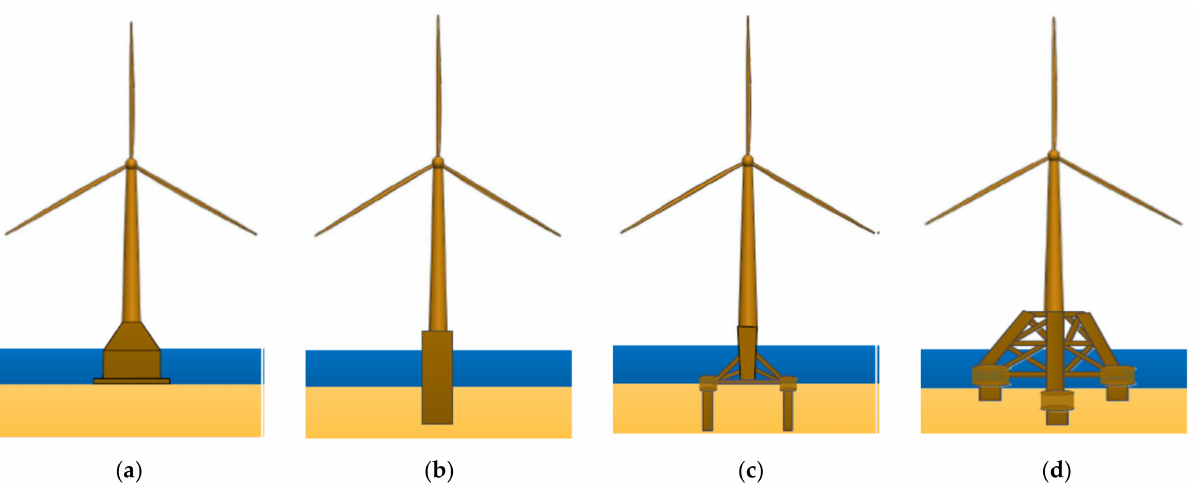
Figure 5. Bottom-fixed offshore wind turbine foundations: ( a ) gravity; ( b ) monopile; ( c )tripod; and ( d )